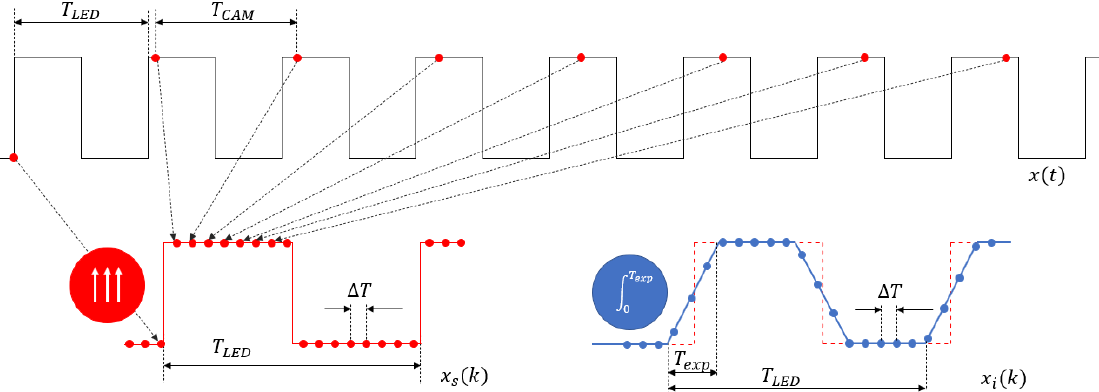
Figure 18. Operation of the equivalent sampling-based measurement method. Black rectangle signal: intensity of the blinking LED . Red dots: samples using ideal (impulse) sampling. Blue dots: samples using integral sampling with integral time of 𝑇 𝑒𝑥𝑝 .